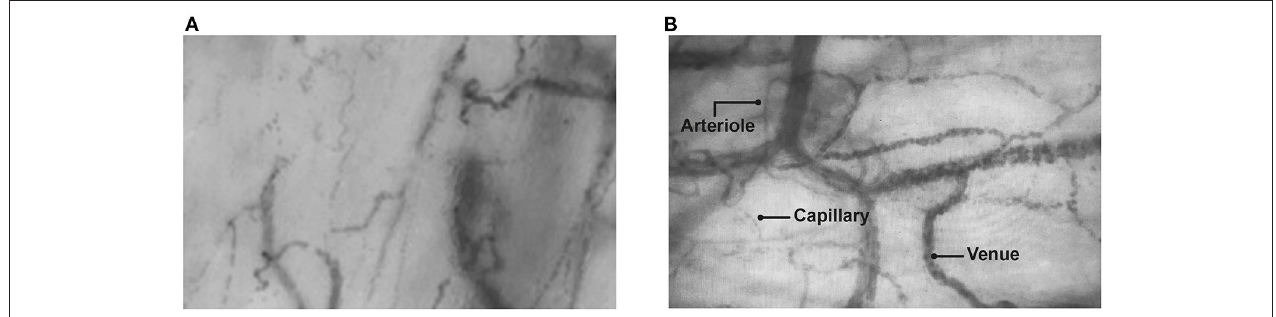
FIGURE 1 | Sublingual video microscopy measurement images. (A) Patient 1 with MIS-C. The total number of vessels is considerably reduced and there is decreased capillary recruitment. In addition, there is a lower capillary density and smaller diameter of venules compared with the control patient. (B) Control patient. Normal appearance of the capillary network in the sublingual area. The capillaries, venules and arterioles are shown with normal distribution and